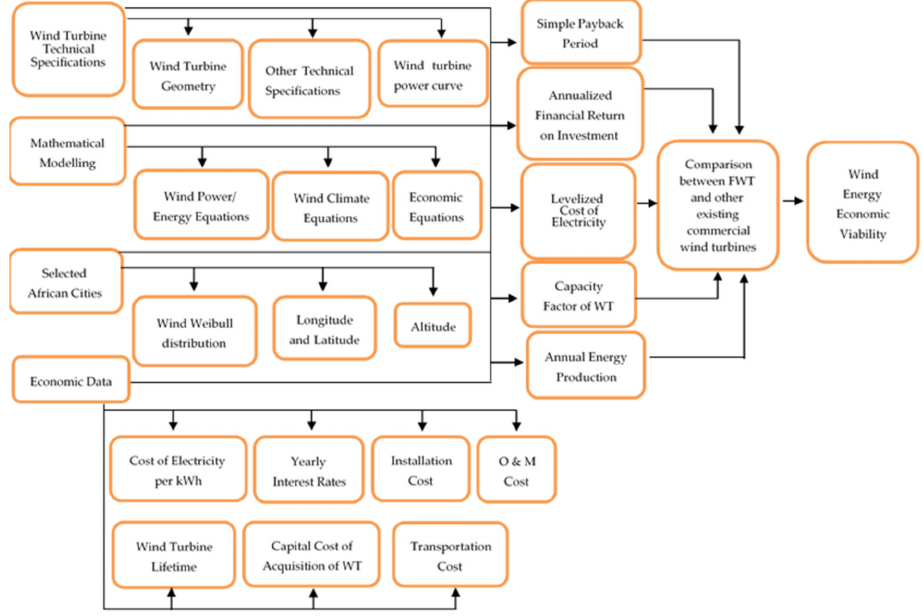
Figure 3. Wind Energy Techno-economic Model Framework: WT-wind